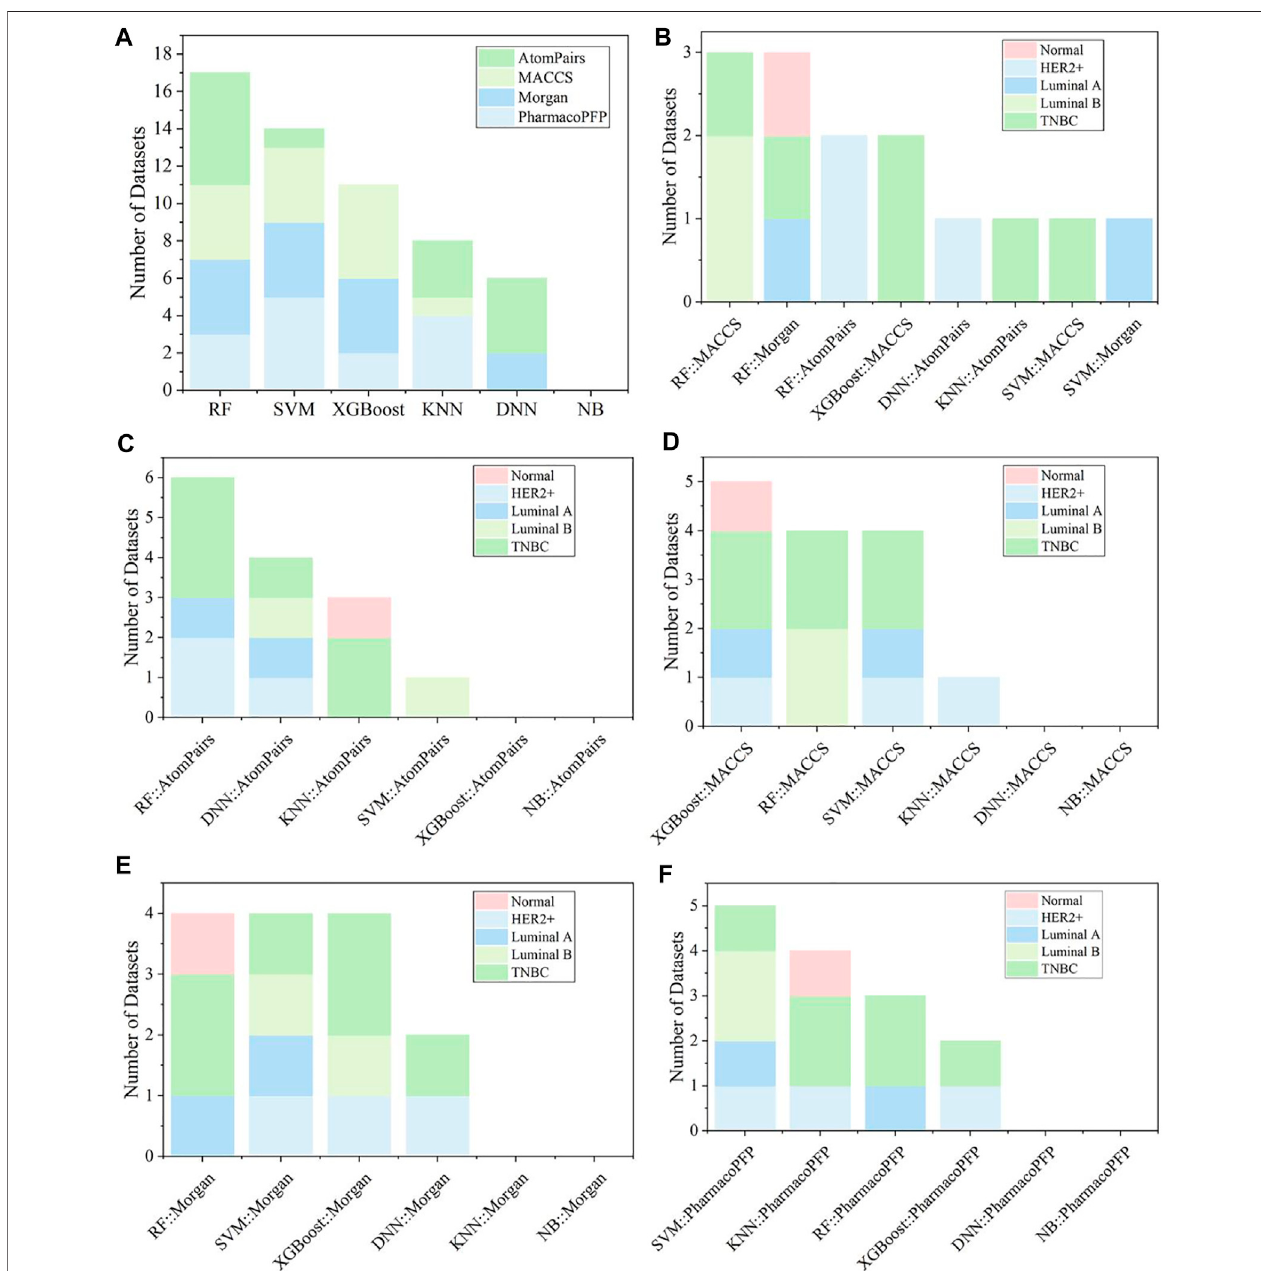
FIGURE5|(A) Summaryoftheoptimalmodelsforeach fi ngerprint-basedfeature. (B) Thebestmodelsamongvarious fi ngerprint-based modelsfordifferentkinds of breast cell lines. The optimal models based on (C) AtomPairs, (D) MACCS, (E) Morgan, and (F) PharmacoPFP for different subtypes of breast cell lines.